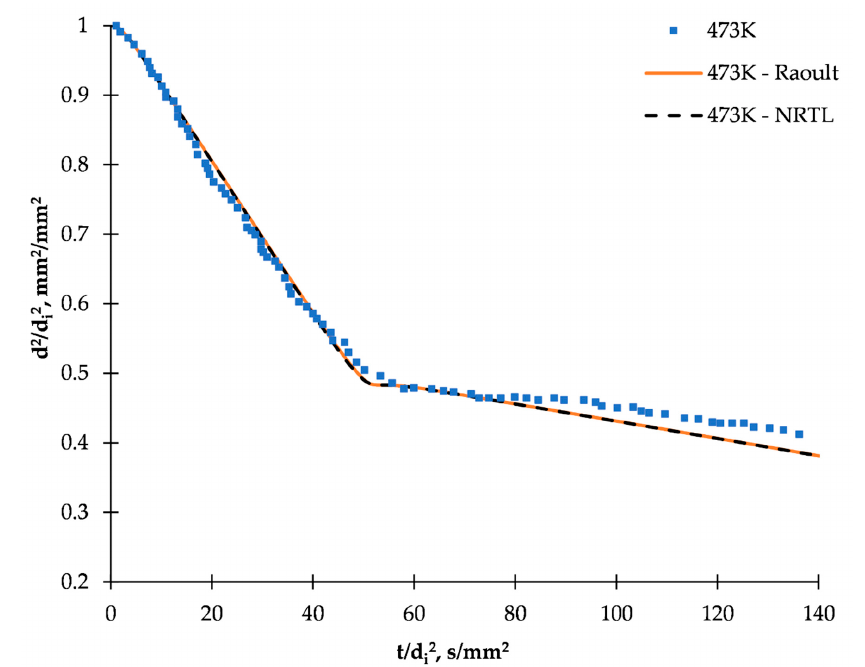
Figure 8. Comparison of the results from the application of nonrandom two liquids (NRTL) model and Raoult’s law.